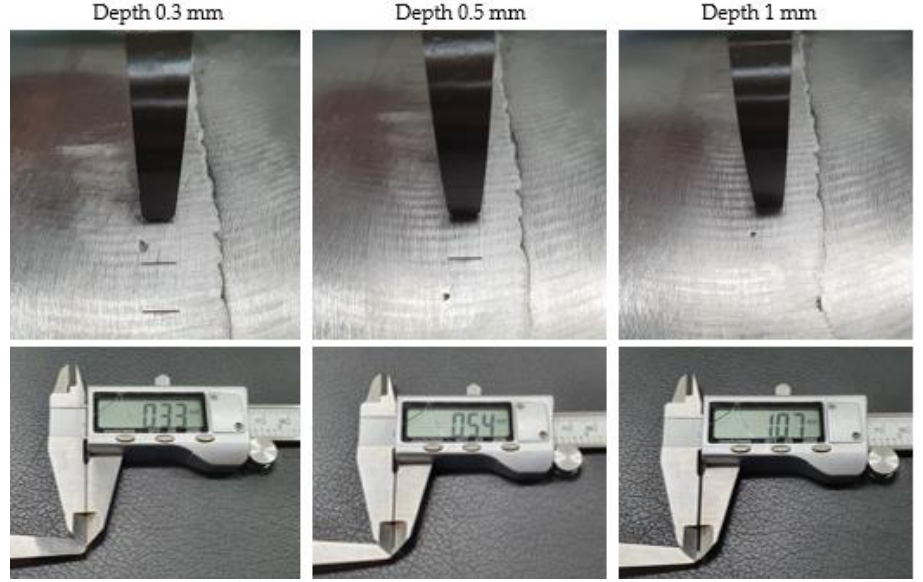
Figure 4. Cracks depth measurement.